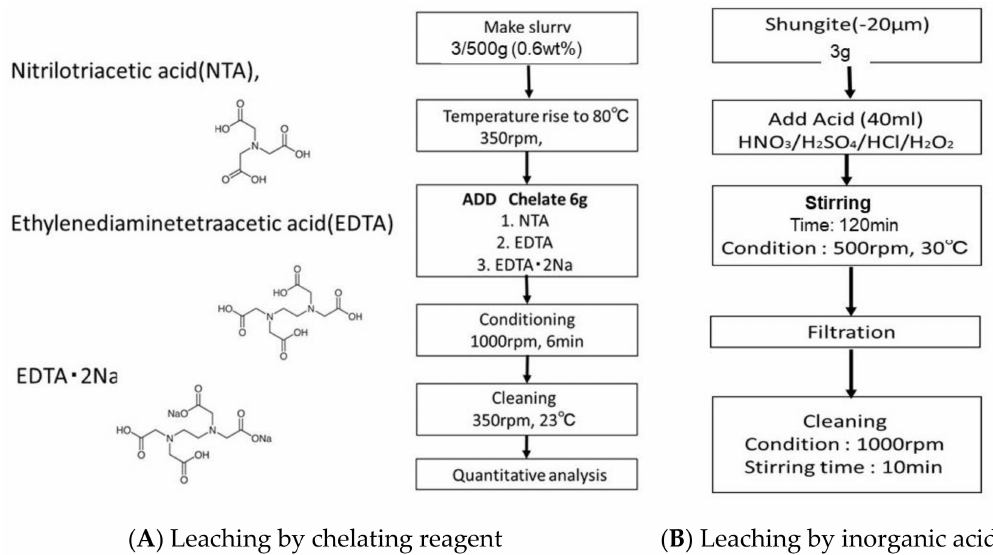
Figure 7. Flowsheet of chemical